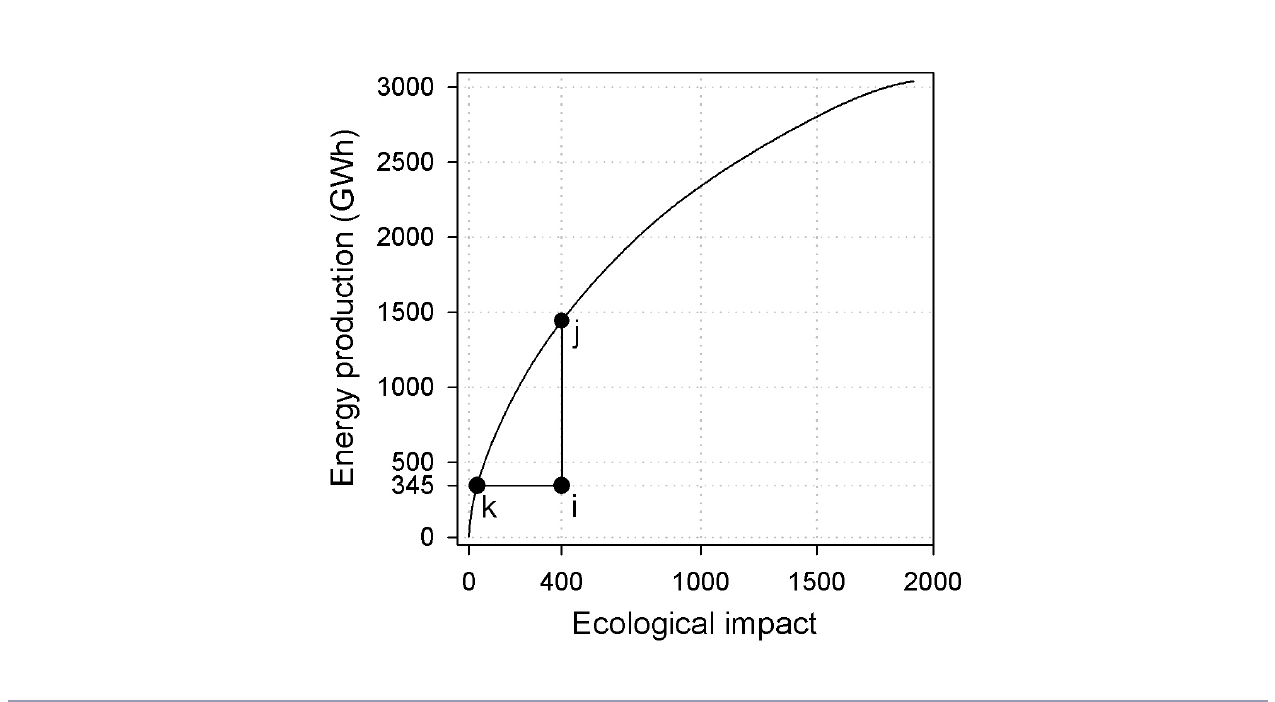
Fig. 5 . Efficiency frontier. Energy production versus ecological impact. Solid line: as calculated for the study region. Point i represents the current situation in the study region; the other two points represent two possible ways of increasing efficiency (see Results: Trade-off